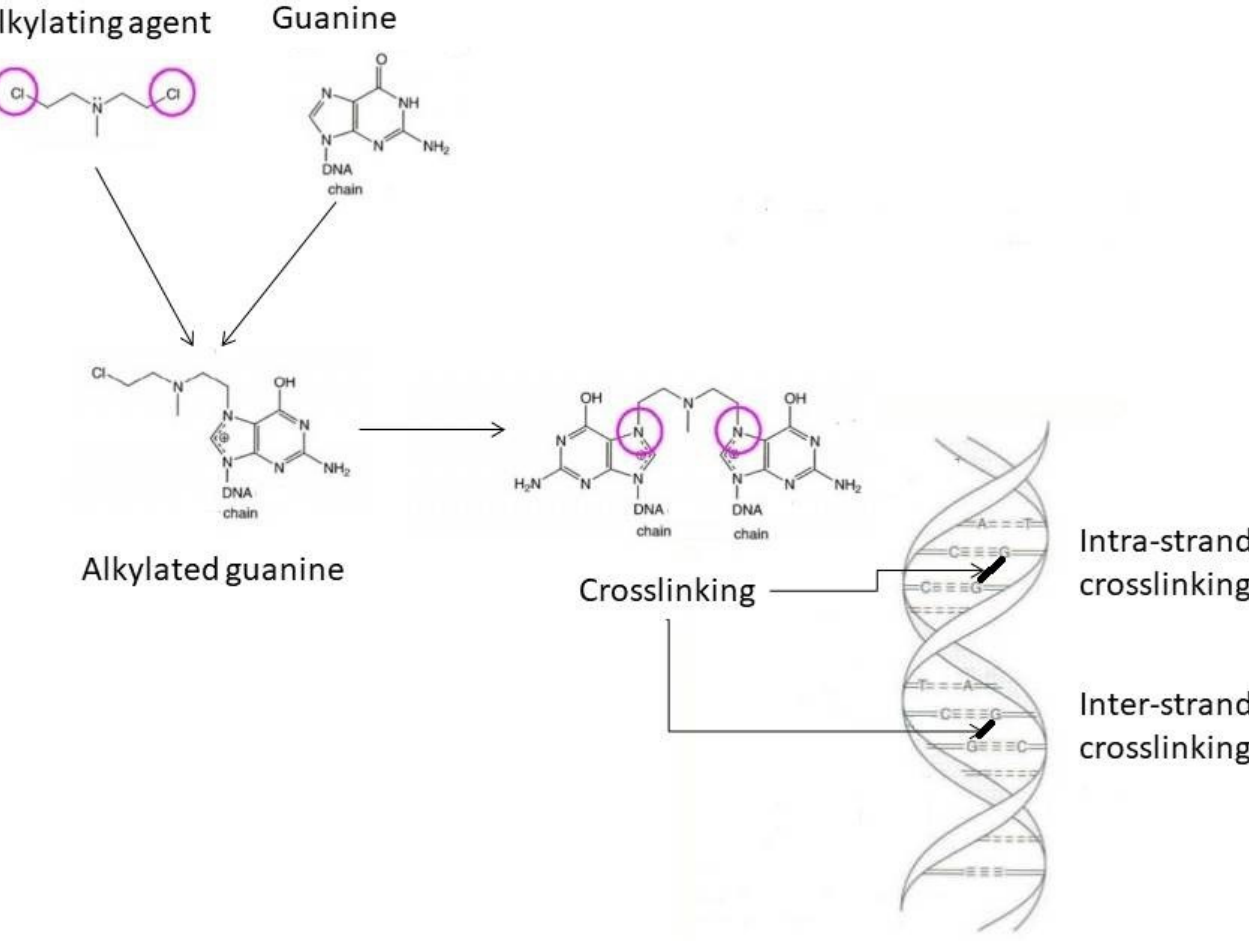
Figure 1. Mechanism of action of alkylating agents. Alkylation of guanine may cause the excision or the opening of the guanine ring, thus interfering in base repairing. Bifunctional alkylating agents also cause intra and inter-strand crosslinking. Cross-linking interferes both with transcription and replication.